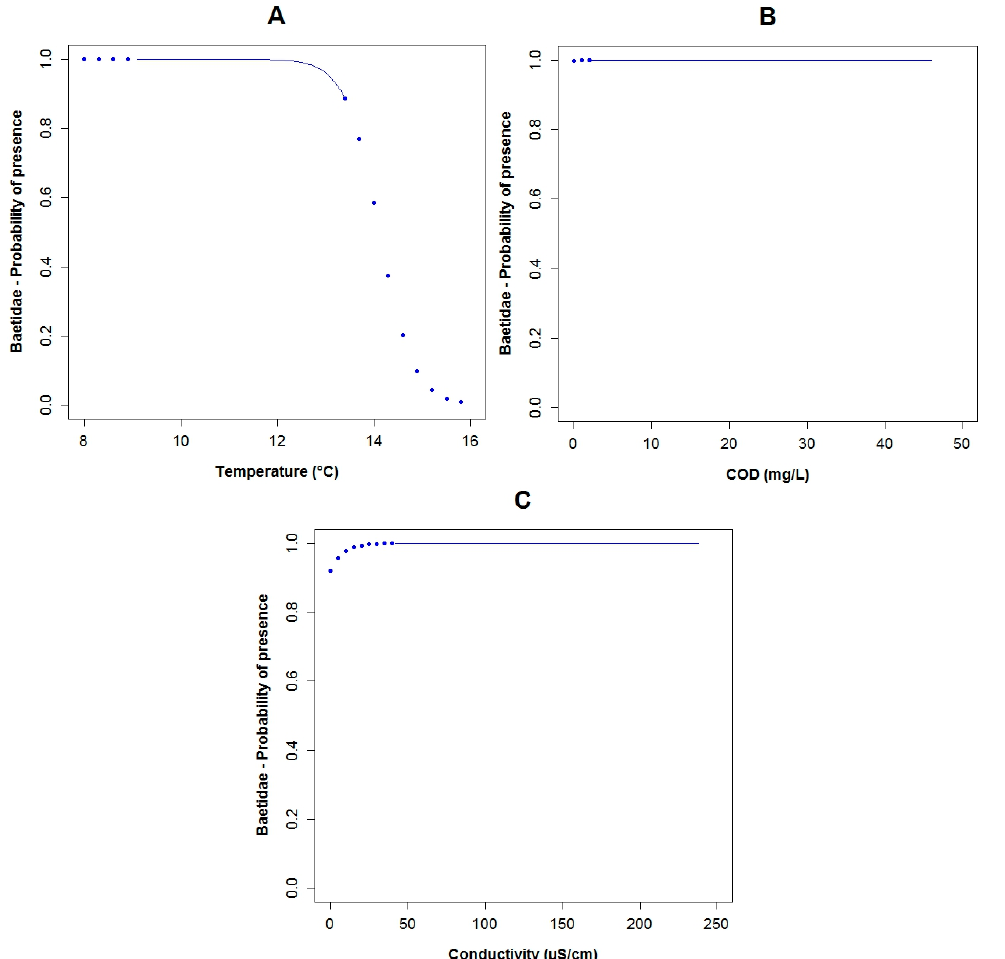
Figure A9. The probability of Baetidae being present in relation to ( A ) temperature; ( B ) COD; ( C ) conductivity. (The blue points in the curves indicate extrapolation outside the observed physicochemical variables range).